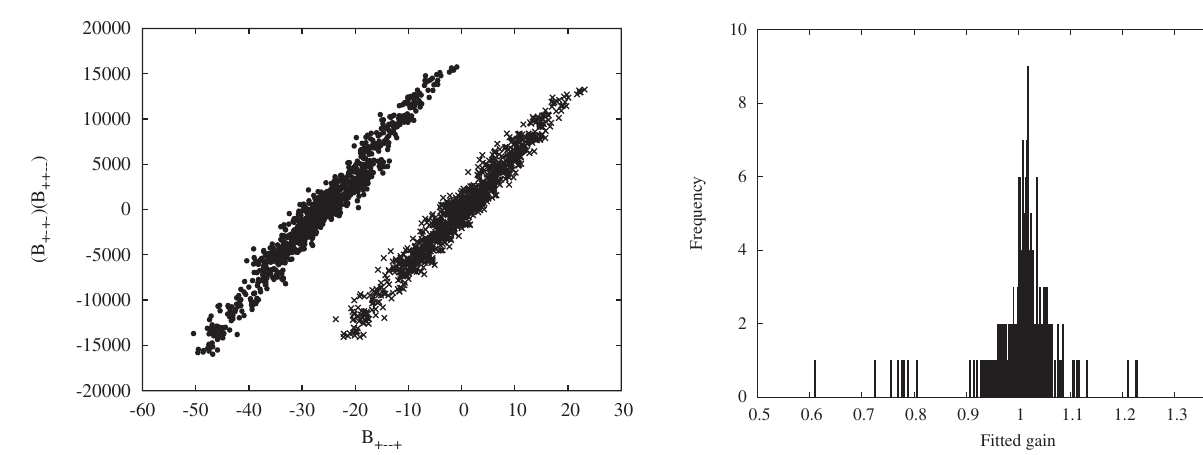
FIG. 12. Distribution of fitted gains for the data plotted in Fig.